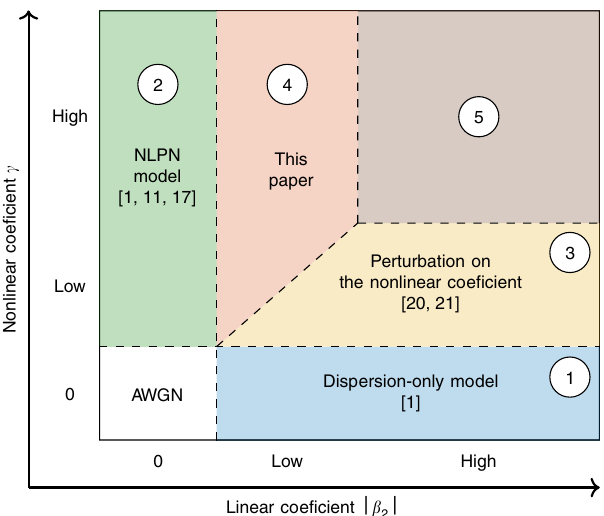
Fig. 1 Validity region for different models for the nonlinear Schrödinger equation. Each region is characterized by a combination of ∣ β 2 ∣ and γ values. The models are derived by using approximations based on the magnitude of these two